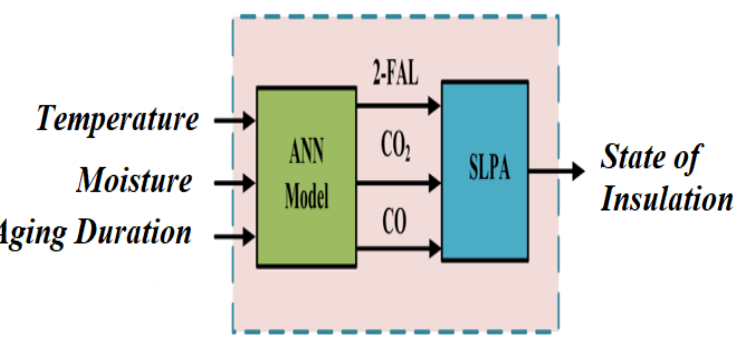
Figure 1. Schematic of the ANN- based transformer’s insulation state.